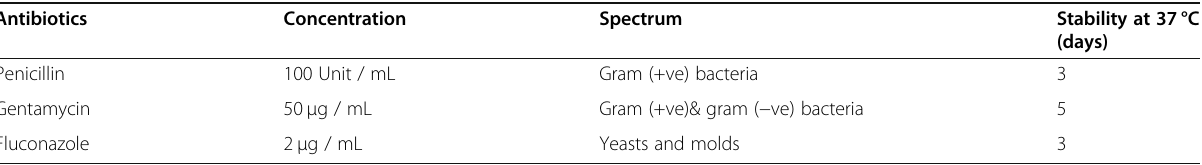
Table 2 Preparation of antimicrobial solution Antibiotics